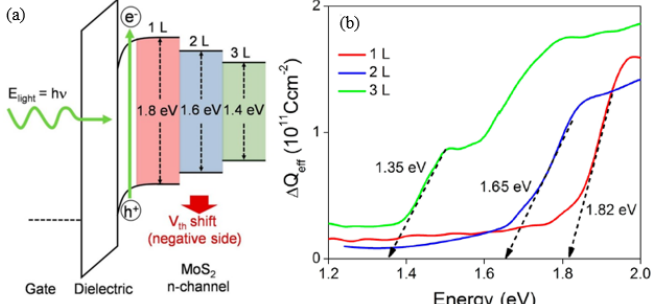
triple ‐ layer MoS 2 (n ‐ channel) under the gate bias for carrier (electron–hole) accumulation. ( b )